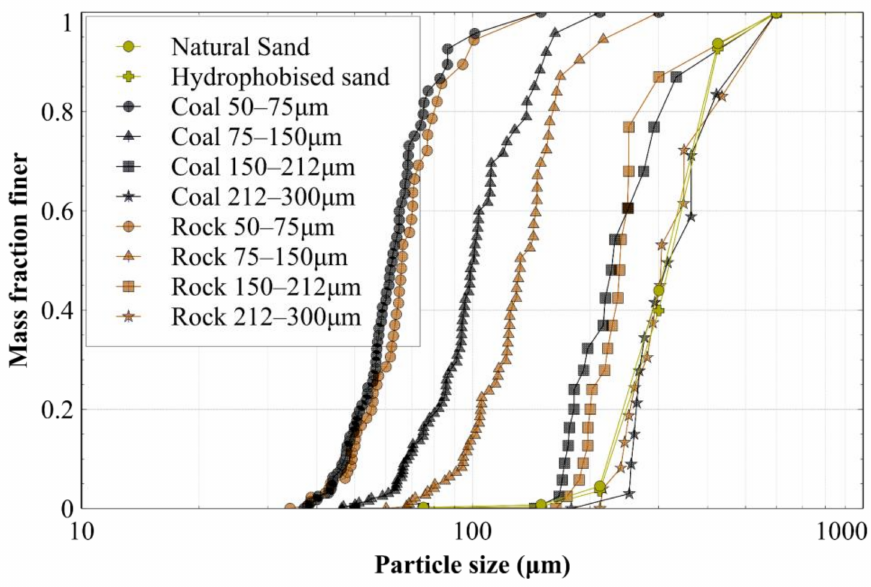
Figure 2. Particle size distribution of the materials used in this